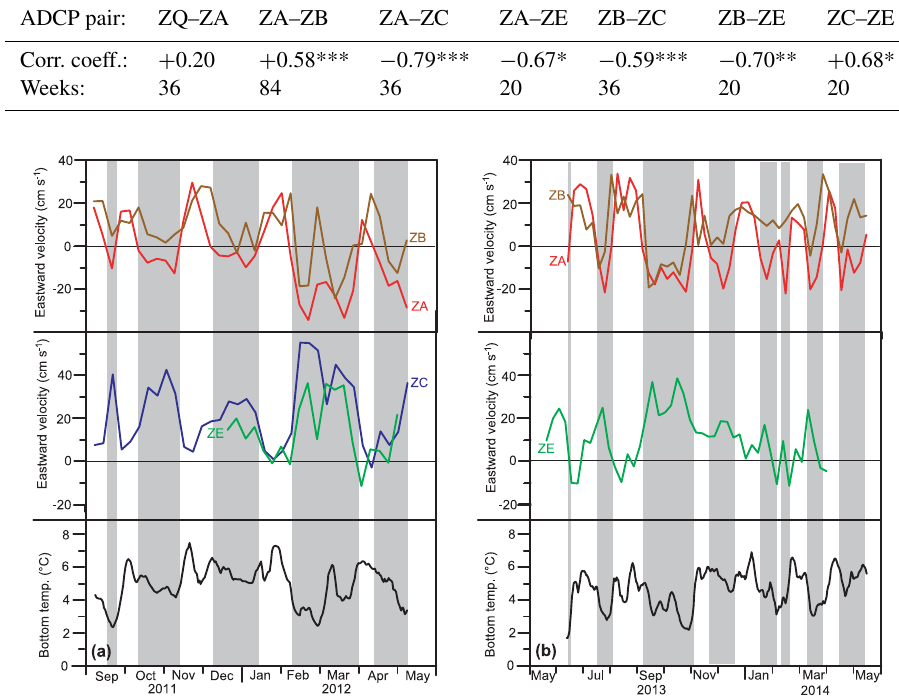
Figure 4. The top and middle panels show weekly averaged eastward velocity at ≈ 200m depth at four ADCP moorings on the Z-section (a) from September 2011 to May 2012 and (b) from May 2013 to May 2014. Top panels are for the Faroese and middle panels for the Scottish side of the channel. Grey areas indicate periods when the velocity at ZA is westward. Due to limited ADCP range, the curve for ZE in (b) is at 268m depth. The bottom panels show weekly averaged bottom temperature at ZA for the same periods.